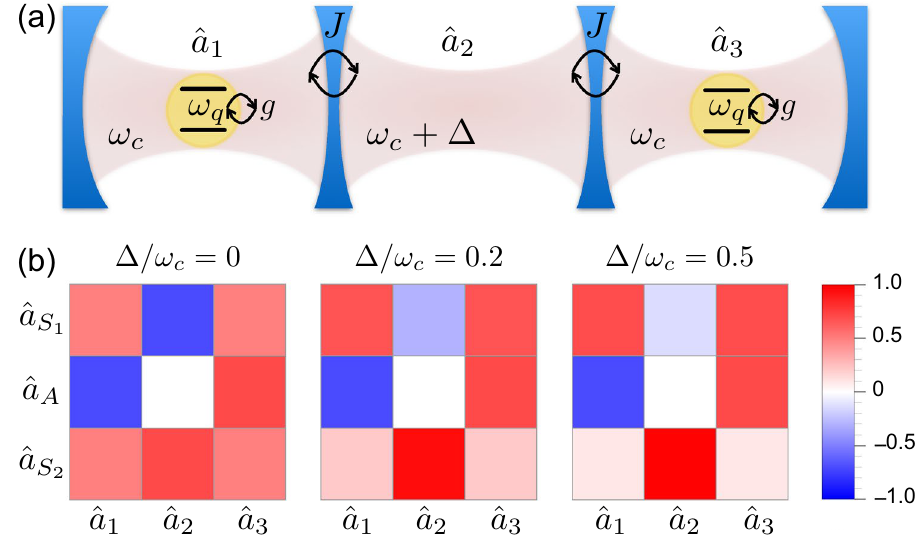
Figure 5. ( a ) Sketch of an array of three optical resonators weakly coupled with their nearest neighbours. The two resonant end cavities ultrastrongly interact with a single qubit with transition frequency ω q , while the central cavity is empty and can be detuned by an amount (cid:31) . The photon hopping rate between the three resonators and the light–matter coupling strength are indicated with J and g , respectively. ( b ) Density plot of the transformation matrix diagonalizing ˆ H ′ C , evaluated for different values of the normalized detuning �/ω c for /ω c 0.3 . While the antisymmetric normal mode is not affected by the detuning, the 0.05 and η g J /ω c ≡ | | = = spatial profile of the two symmetric normal modes changes significantly with increasing values of (cid:31) . Specifically, a S for higher values of the detuning, the lower-energy mode becomes totally delocalized in the end cavities, 1 ˆ a S while the higher-energy mode is completely localized in the central 2 ˆ